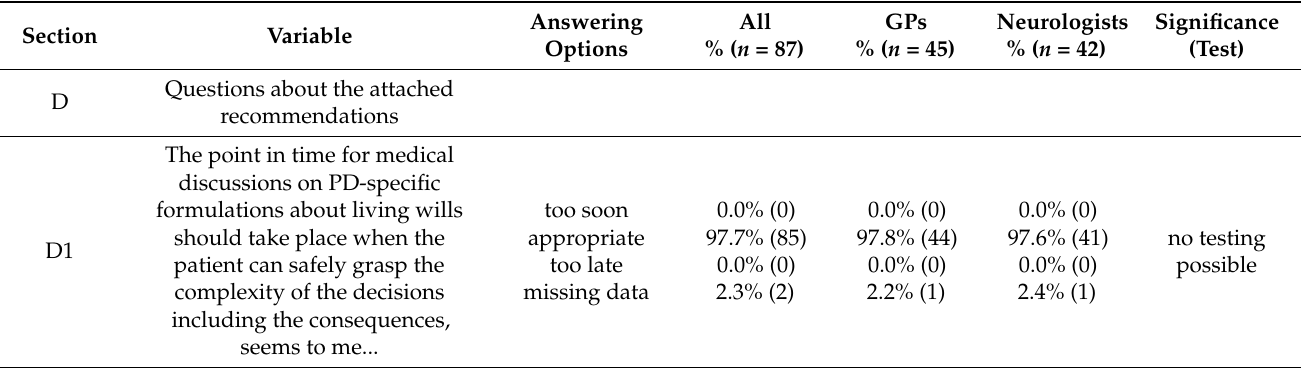
Table 4. Evaluation of the previously established PD-specific